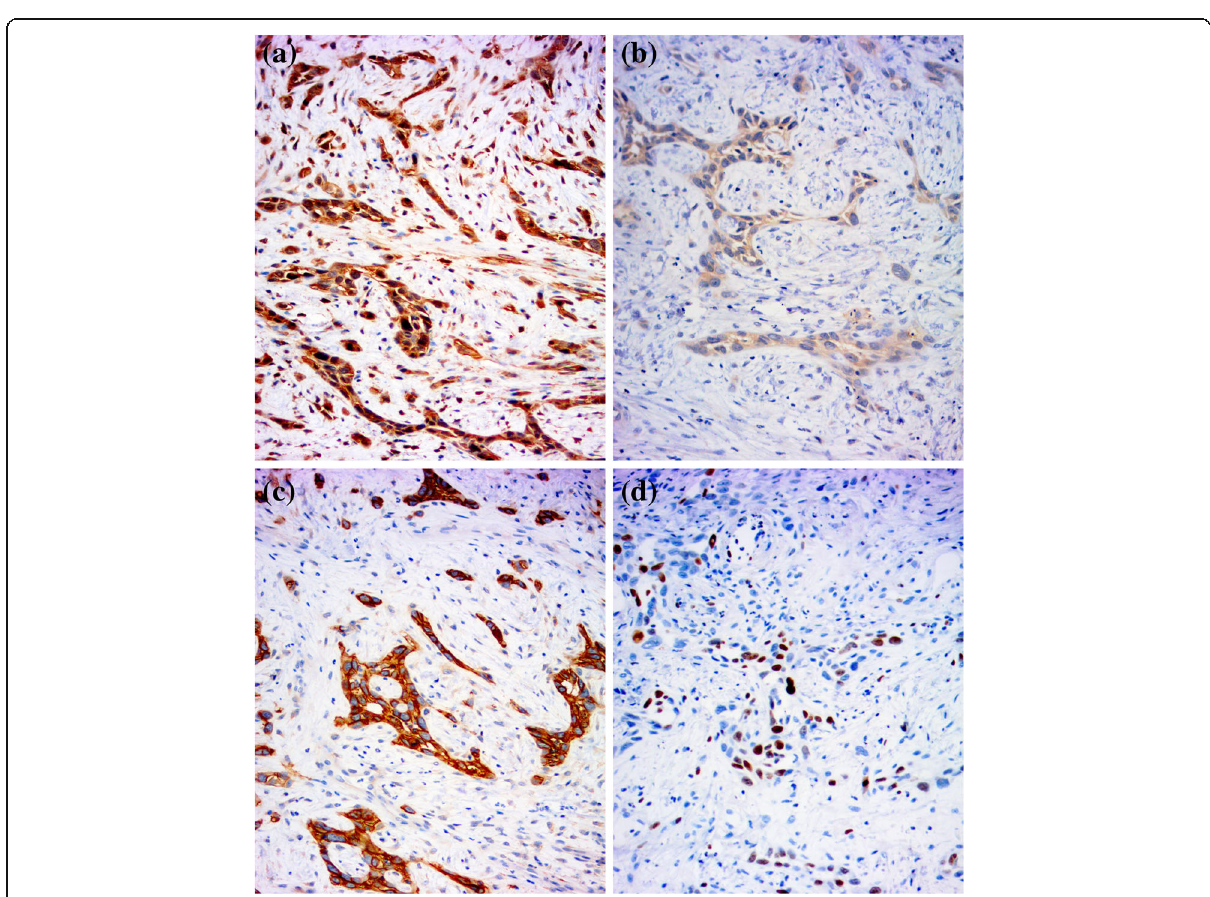
Fig. 3 AHR, CYP1A1, EGFR, and Ki-67 in a cSCC case. a Strong positive AHR immunoreactivity in both the nuclei and cytoplasm in SCC cells. b Weak CYP1A1 immunoreactivity with a cytoplasmic pattern in SCC cells. c Strong positive EGFR immunoreactivity in SCC cells. d Moderate Ki-67 immunoreactivity in SCC cells. (immunoperoxidase ×